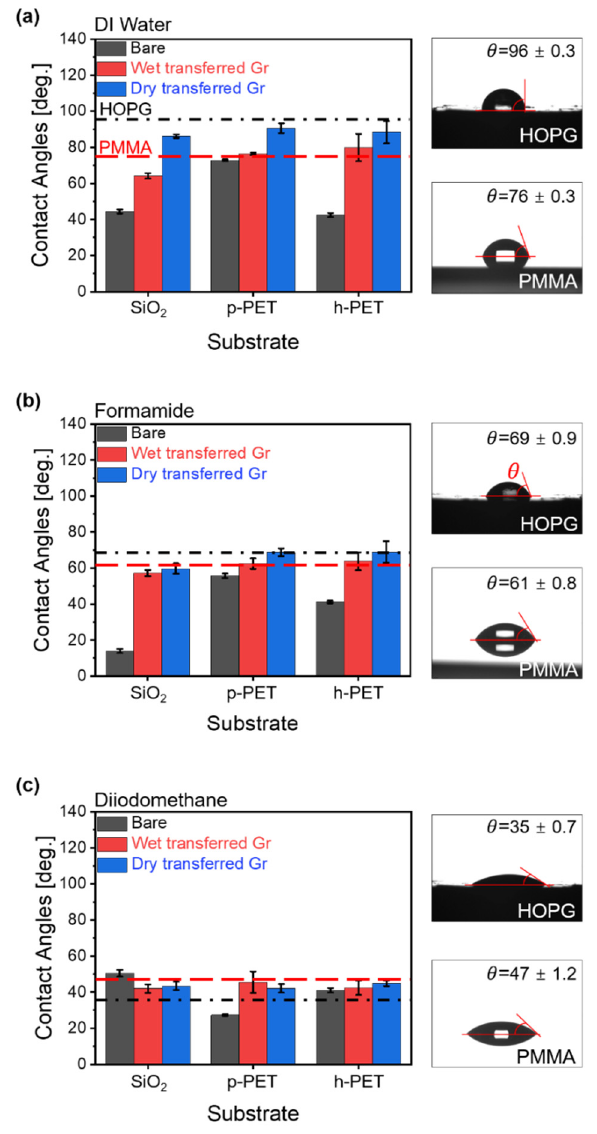
Figure 4. Contact angles of ( a ) deionized (DI) water, ( b ) formamide, and ( c ) diiodomethane on bare substrates, and wet- and dry-transferred Gr/substrate. The black and red dotted lines represent the contact angles of graphite (HOPG) and PMMA, respectively.